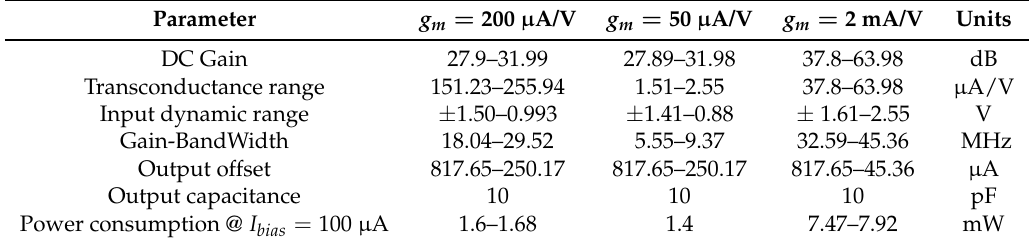
Table 3. Performance ranges of the programmable OTAs with g m centered at 200 µ A/V, 50 µ A/V and 2 mA/V.